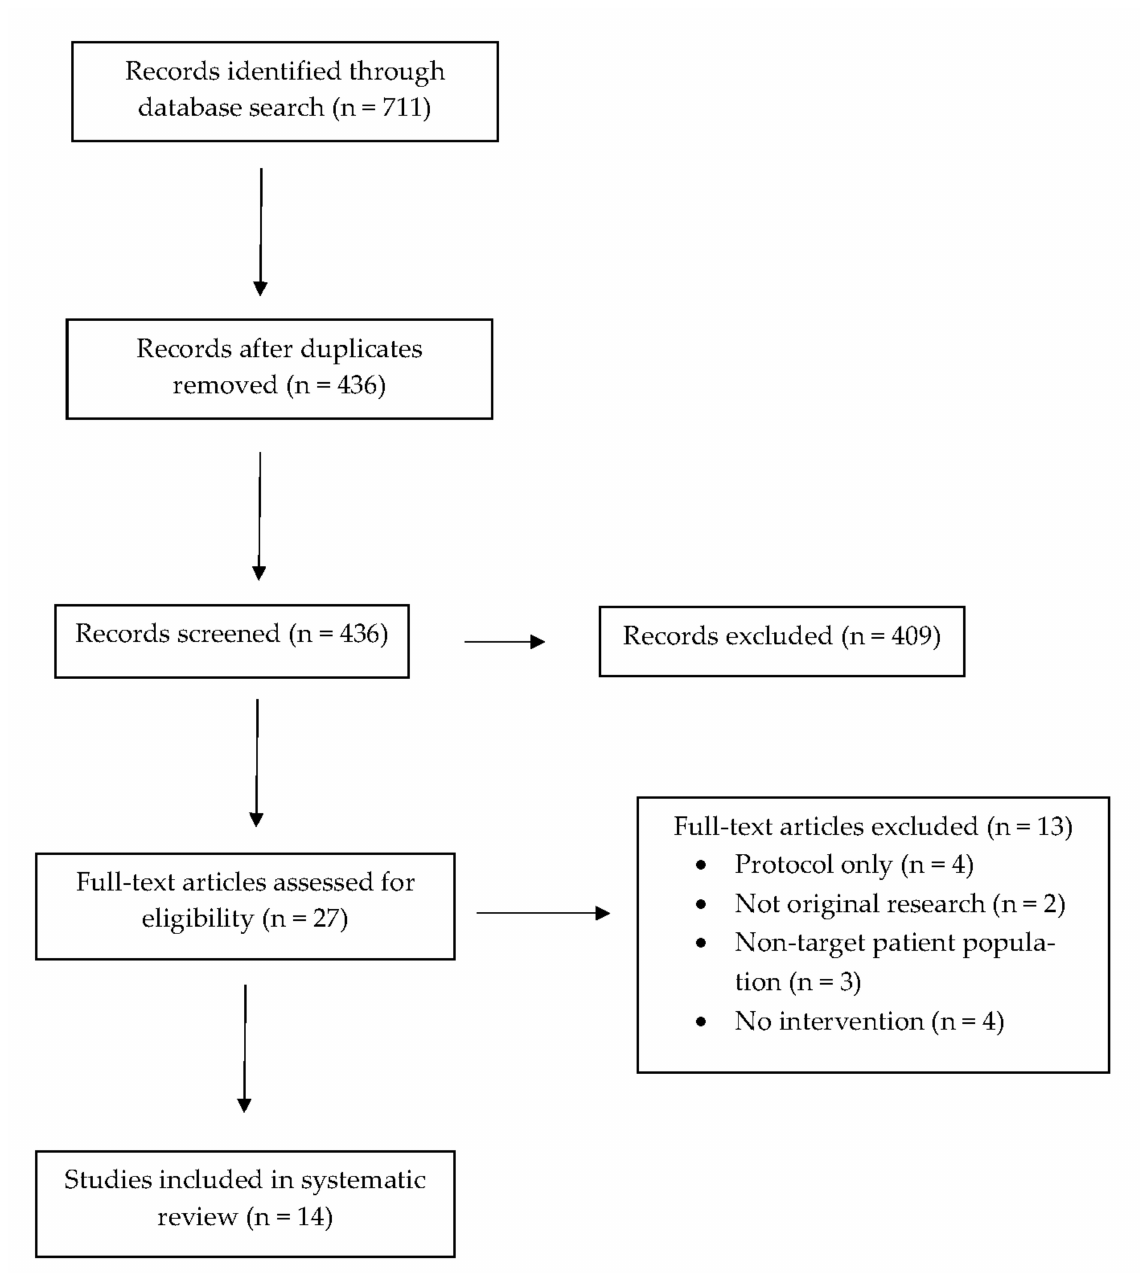
Figure 1. Narrative Review